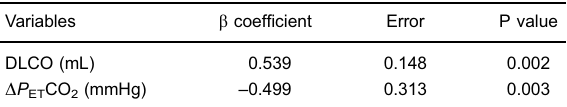
. V O 2 (mL (cid:3) kg (cid:4) 1 (cid:3) Table 4. Blood gas analysis and blood count in patients with COVID-19 on hospital admission.